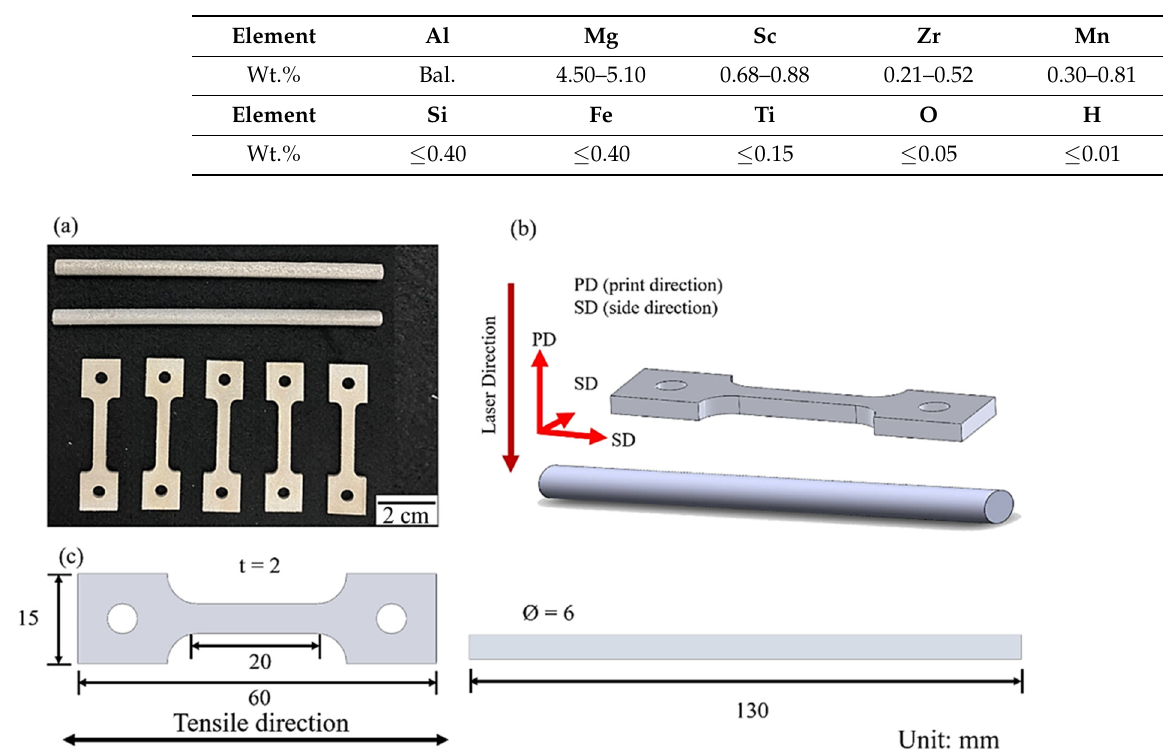
Figure 2. Schematic of the specimen of the SLM Al–Mg–Sc–Zr alloy: ( a ) macroscopic morphology, ( b ) manufacturing direction, and ( c ) size of tensile specimen and fatigue specimen. Table 1. Parameters of the SLM process. Table 3. Heat treatment parameter of SLM Al–Mg–Sc–Zr